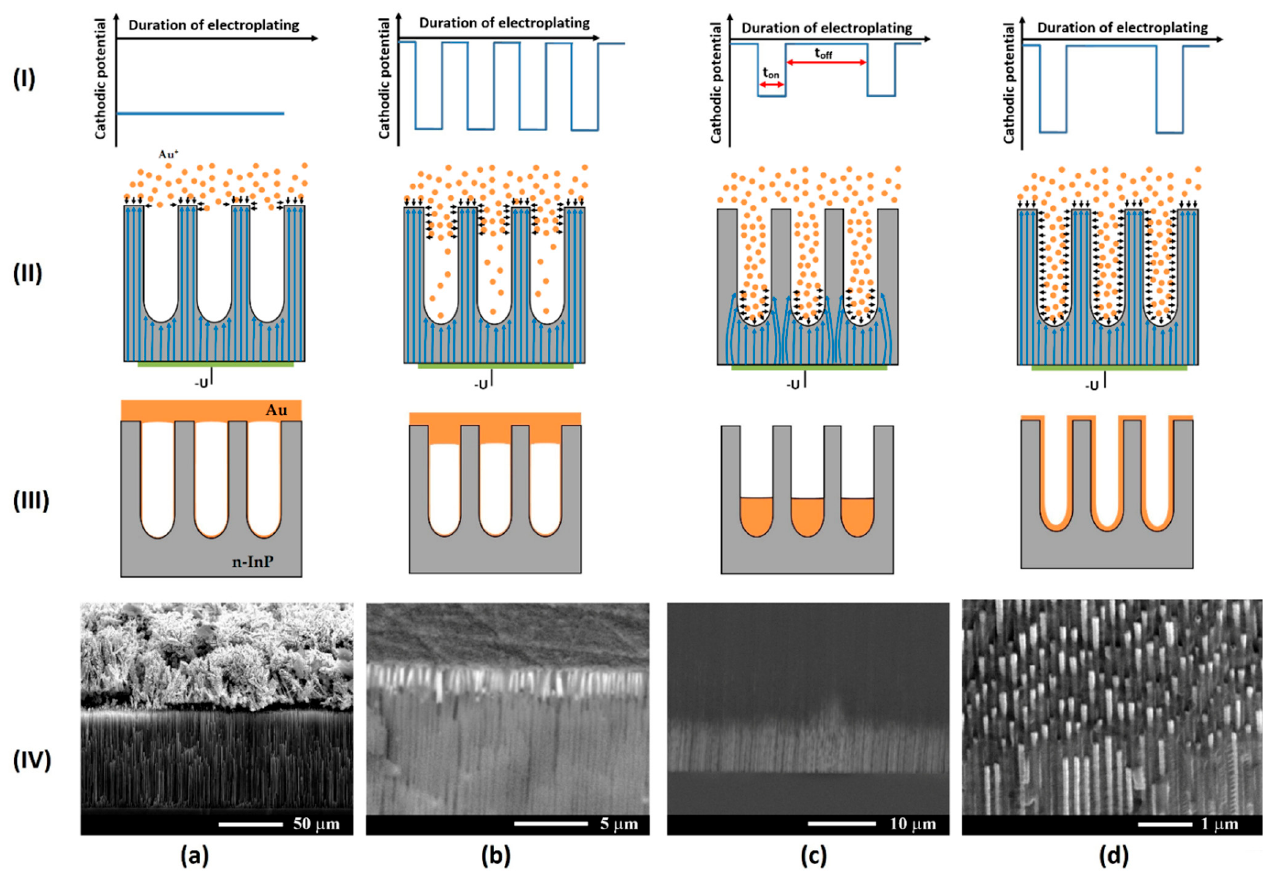
Figure 3. Site-selective pulsed electroplating of metal species in porous InP semiconductor nanotemplates at different deposition parameters: ( a ) continuously applied voltage leading to deposition on top of the template (t off = 0); ( b ) deposition on and underneath surface at small delay applied between the pulses (t off ); ( c ) selective deposition of metal at the bottom of pores by applying a small voltage pulse amplitude; and ( d ) uniform deposition along the whole template thickness at optimized pulse width, delay between pulses and voltage amplitude resulting in the formation of Pt nanotubes. In row ( I ), a schematic representation of applied pulses is presented. In row ( II ), a schematic art-view of the metal species penetration inside pores, depending on the pulse parameters is presented; the blue lines illustrate the current lines. In row ( III ), a schematic representation of the deposited metal in porous InP template is presented, and row ( IV ) demonstrates the site-selective deposition by SEM images in cross-sectional view.